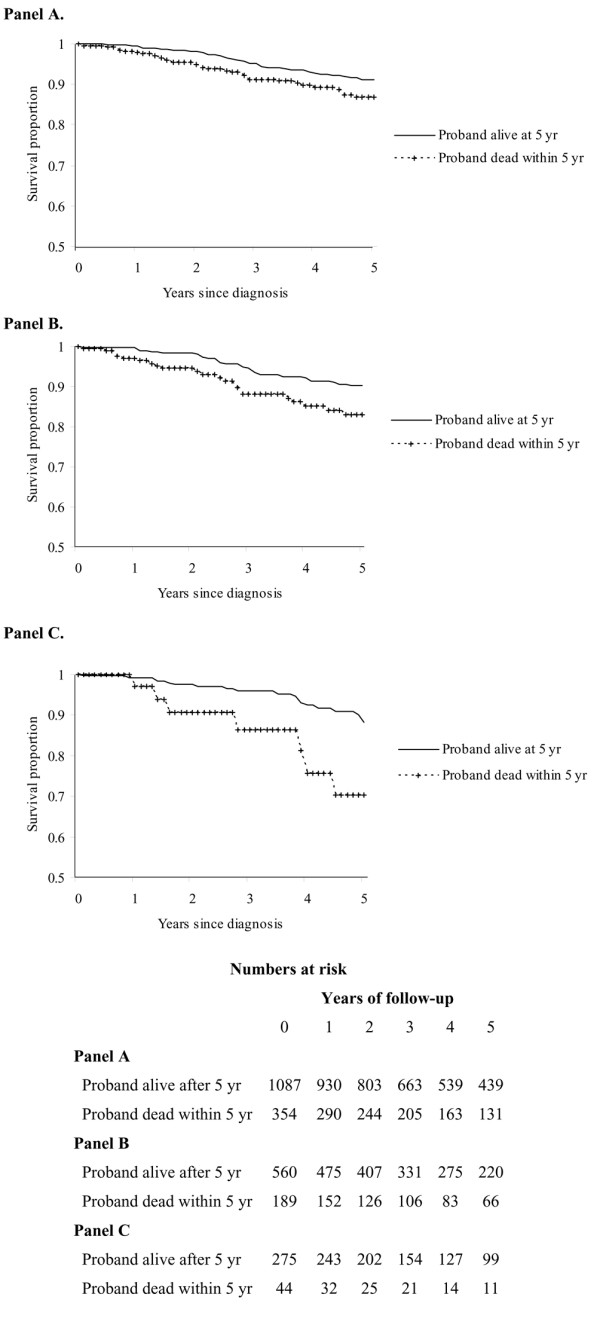
Kaplan-Meier estimates of breast cancer-specific mortality of women whose cancer was diagnosed since 1991 and who have a first-degree relative with breast cancer. Estimates are stratified by proband's cause-specific outcome. (a) One thousand seven hundred seventy-eight daughters with mother as proband. (b) Eight hundred forty-nine daughters with a mother younger than 70 years of age as proband. (c) Three hundred forty-eight sisters with an older sister as proband.